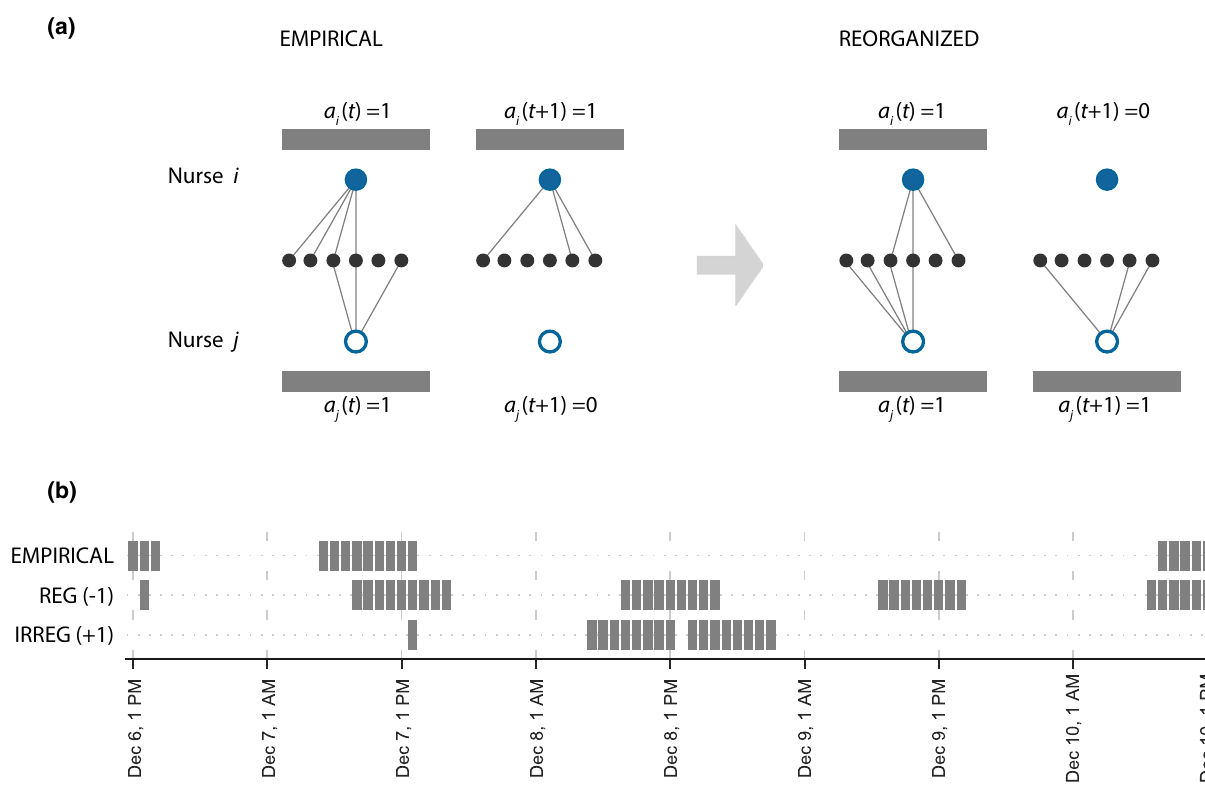
Figure 2. Intervention on nurse scheduling. ( a ) Schematic visualization of the intervention, with the exchange of tasks between nurse i (filled blue node) and nurse j (void blue node), at times t (while they are both at work) and t + 1 (while nurse j is not at work in the empirical schedule, and would exchange her shift with nurse i in the reorganized schedule). Links represent contacts with other individuals (black nodes). The reorganized nurse schedule (right) is compared to the empirical one (left) obtained from the contact data. ( b ) Example of an empirical nurse schedule along with the re-organized ones obtained with k = − 1 and k = 1 , leading to regular and irregular individual schedules, respectively. Grey blocks correspond to hours when the nurse is at